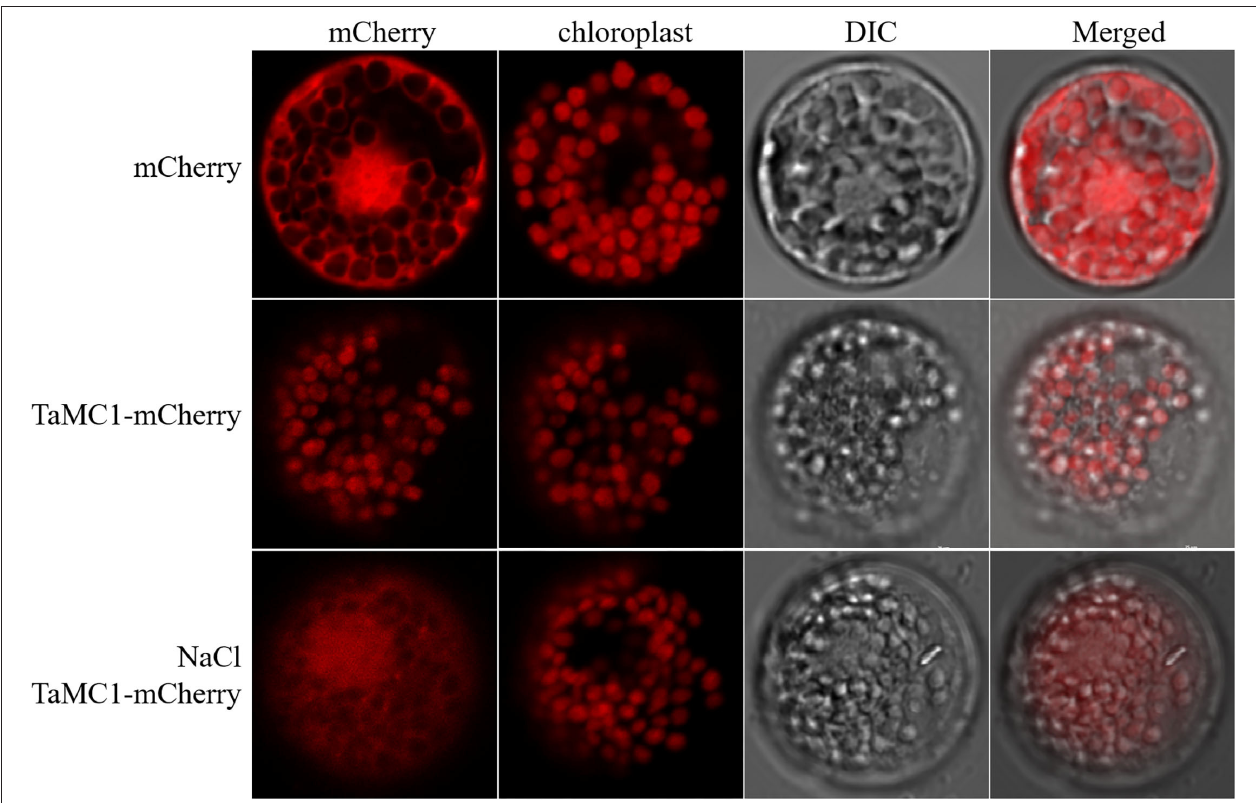
FIGURE 3 | Subcellular localization of TaMCA-Id . Wheat protoplasts were transformed with pAN583 : mCherry or GFP : mCherry via the polyethylene glycol (PEG)-mediated method. TaMCA-Id was mainly localized to the chloroplast in wheat protoplasts, and exhibited nucleocytoplasmictrafficking under NaCl treatment. TaMC1 in the figure indicates